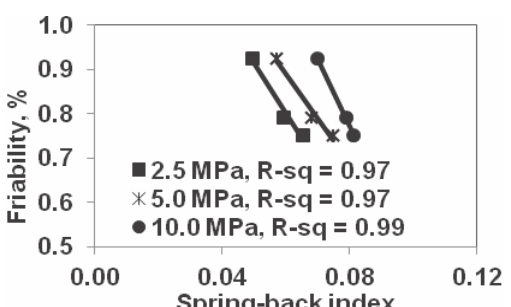
Fig. 8 Relation between tablets ʼ indentation hardness and spring-back index (determined at 20 MPa/ min loading rate) at different pressures.